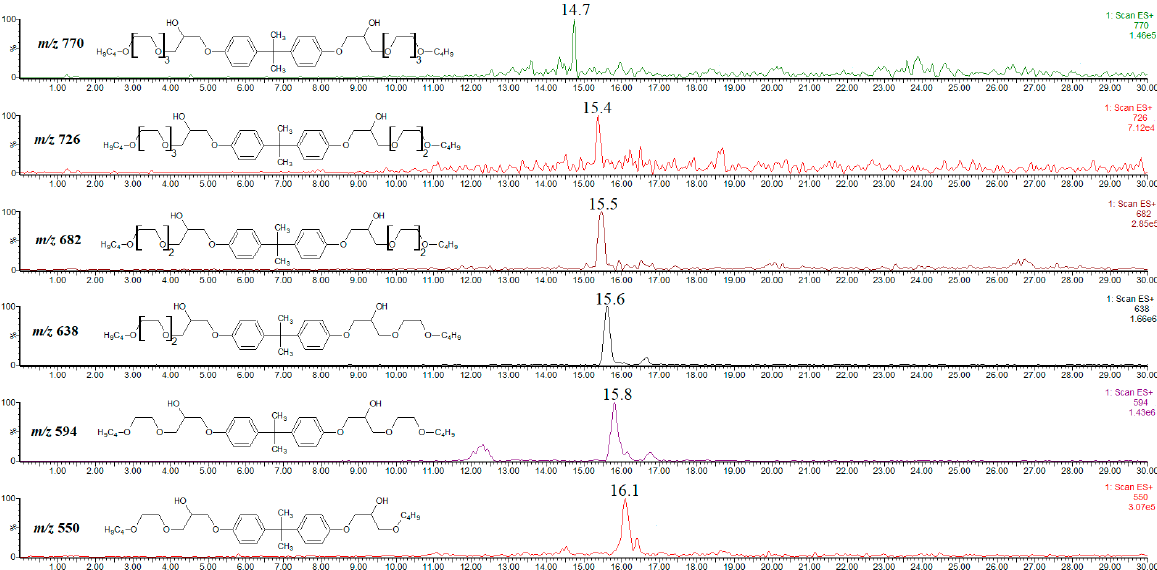
+ ions of ethoxylated butoxyethanol-BADGE 4 ]